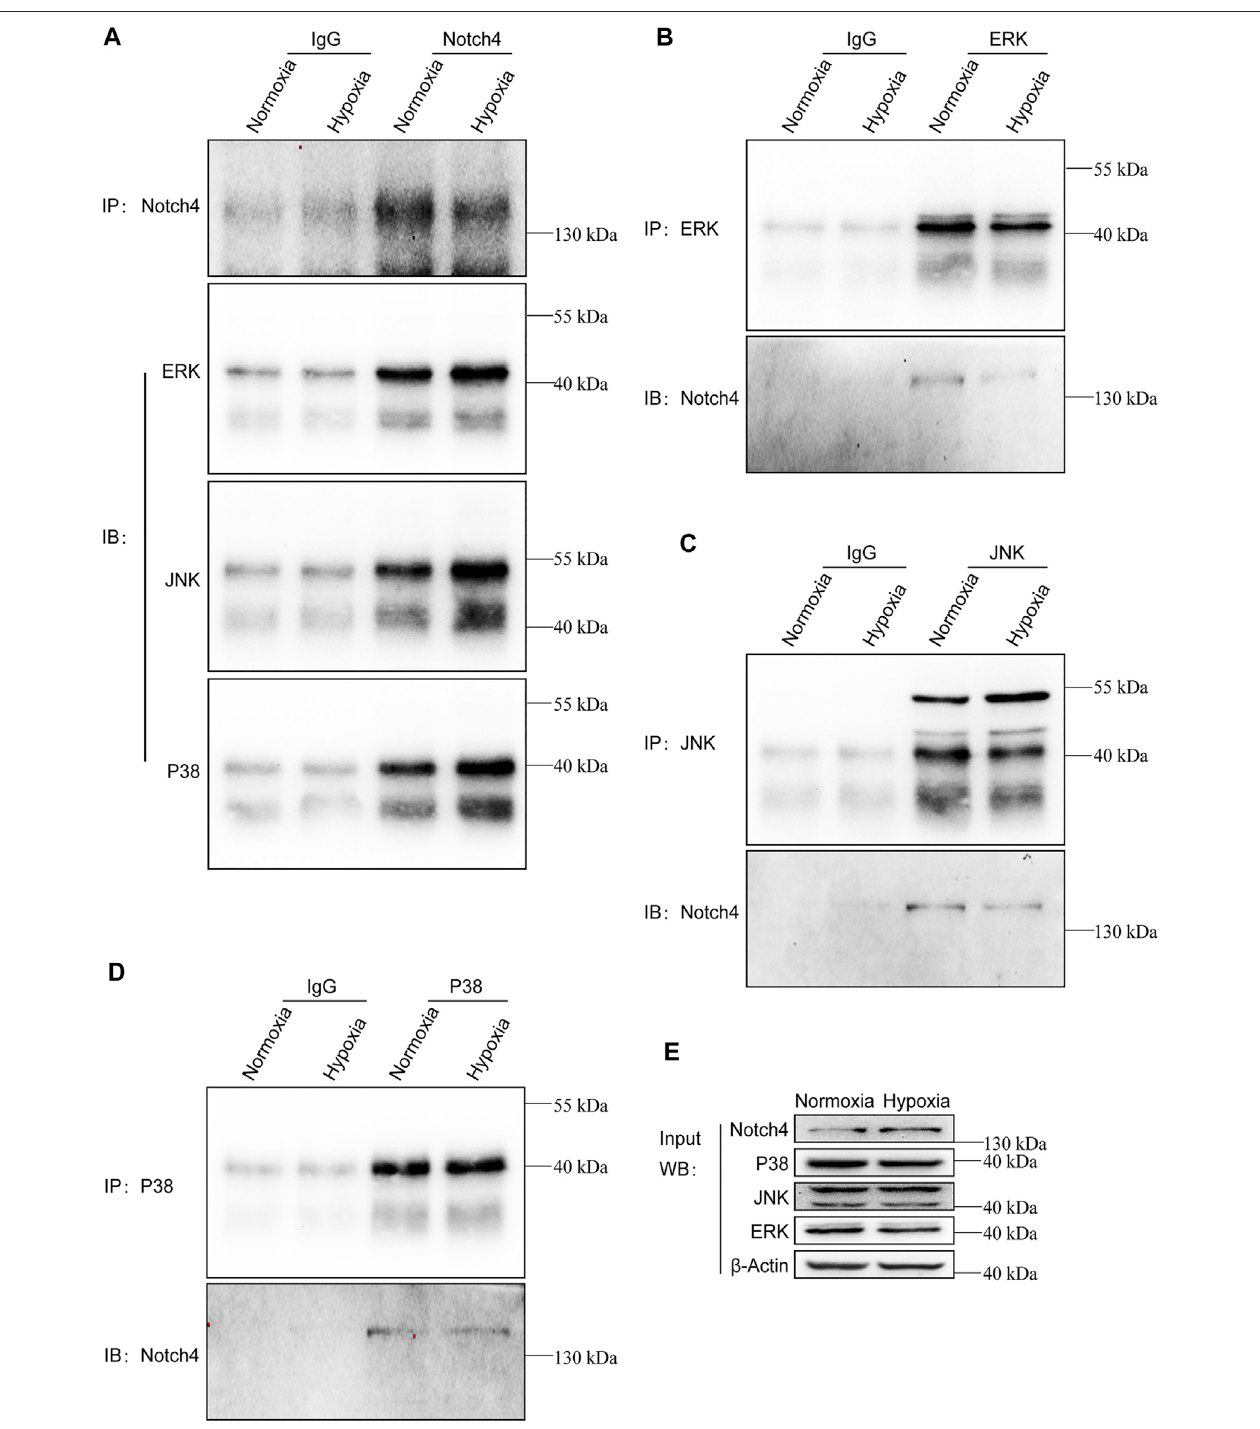
FIGURE 7 | Notch4 interacts with ERK, JNK, and P38 in A549 cells. Endogenous co-immunoprecipitation was performed in A549 cells exposed to normoxia or hypoxia for 24 h. (A) Western blot analysis for endogenous ERK, JNK, and P38 after IP of endogenous Notch4 from A549 cells exposed to normoxia or hypoxia. (B) Western blot analysis for endogenous Notch4 after IP of endogenous ERK from A549 cells exposed to normoxia or hypoxia. (C) Western blot analysis for endogenous Notch4afterIPofendogenousJNKfromA549cellsexposedtonormoxiaorhypoxia. (D) WesternblotanalysisforendogenousNotch4afterIPofendogenousP38 from A549 cells exposed to normoxia or hypoxia. (E) Whole-cell lysates were used for IB with the indicated antibodies to show expression. IP, immunoprecipitation; IB, immunoblot. ERK, extracellular signal-regulated kinase; JNK, c-Jun N-terminal kinase.